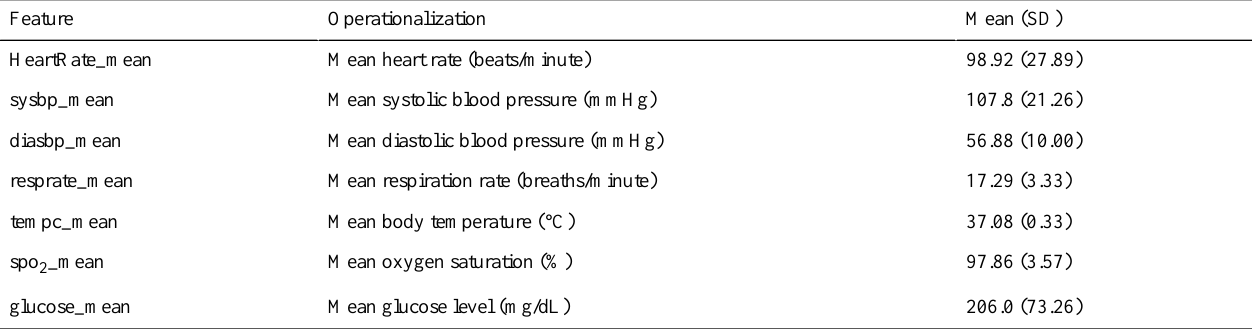
Table 4. Sample data from an individual patient before applying the quantiles approach.